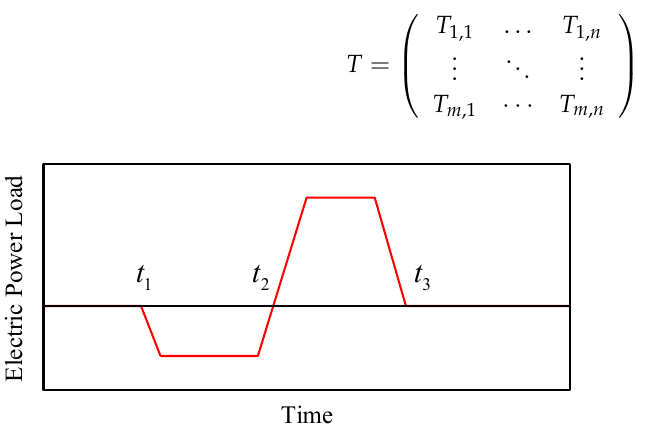
Figure 4. Schematic diagram of load rebound.